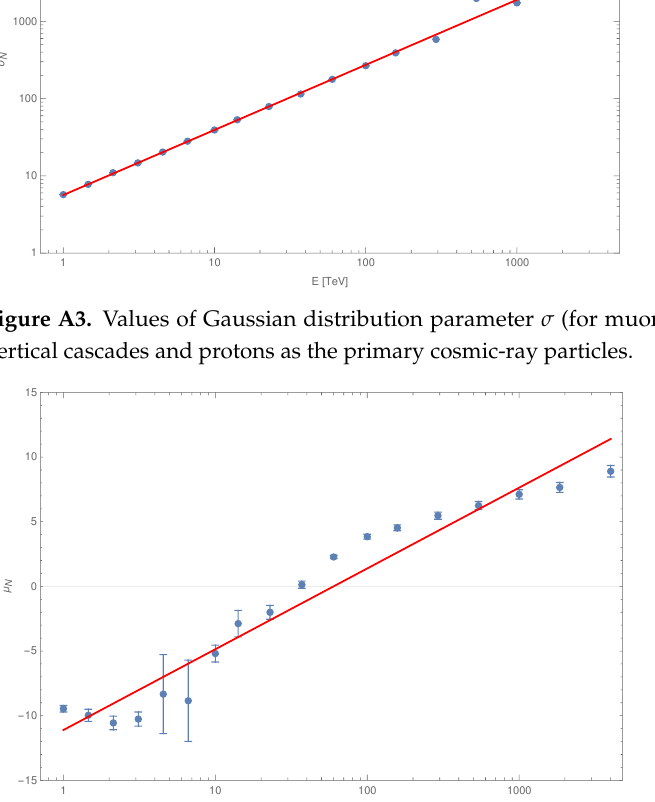
Figure A4. Values of Gaussian distribution parameter µ (for electrons) for different energies of the vertical cascades and protons as the primary cosmic-ray particles.